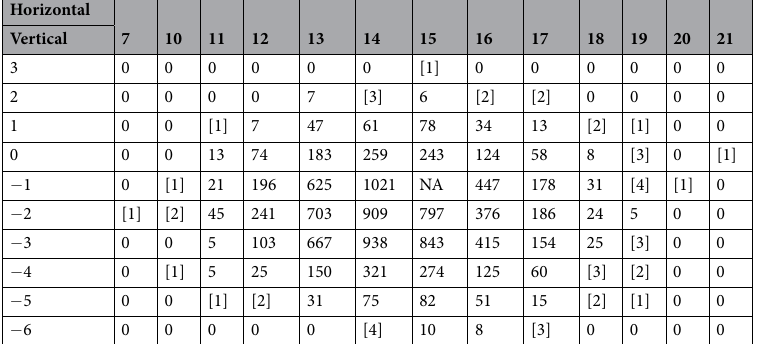
Table 1. The detailed spatial distribution of NBSL including NBSLs with less than 5 eyes enclosed by brackets, which were excluded from Gaussian process regression due to possible reliability issues. The NBSL at (15°, − 1°) is denoted as missing value since all NBSL of (15°, − 1°) is excluded due to the reason we described in Method